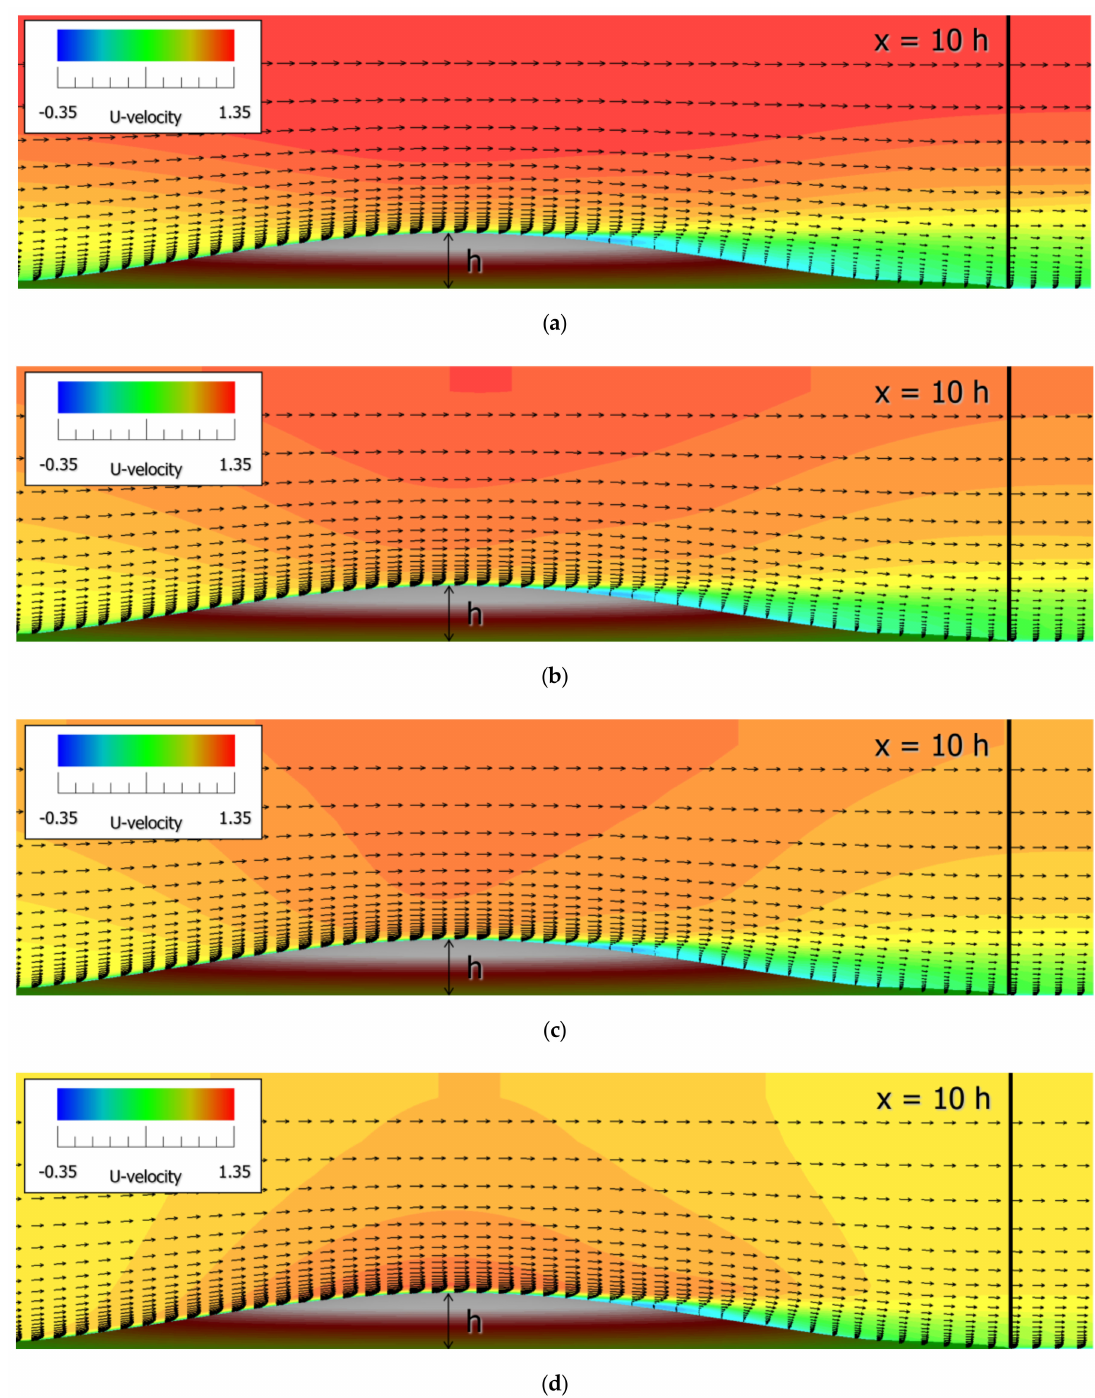
Figure 15. Comparison of flow patterns for a time-averaged flow field under various inflow conditions in the gentle hill scenario. ( a ) Power law index N = 4; ( b ) Power law index N = 7; ( c ) Power law index N = 10; ( d ) Uniform